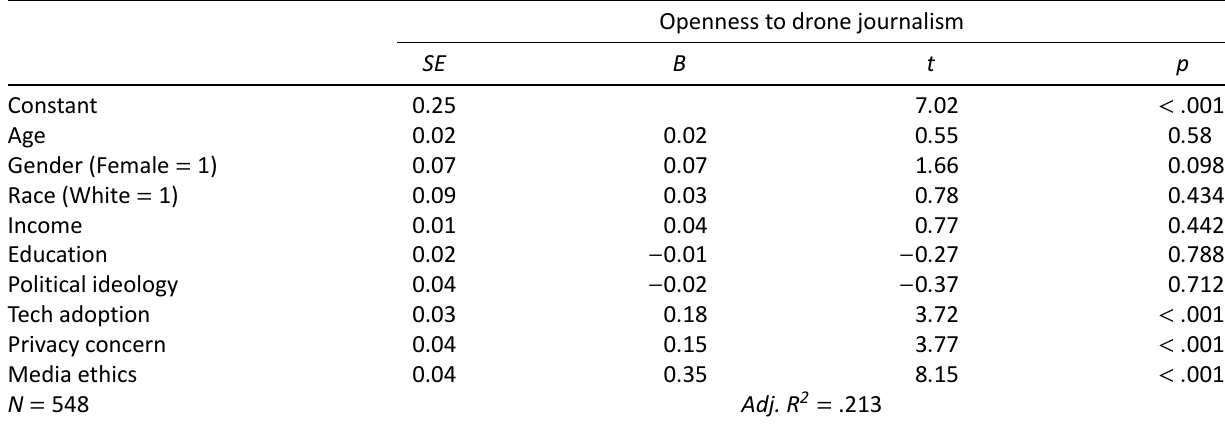
Table 5. The influence of privacy concerns, early technology adoption and perception of media ethics on the openness to civilian drone use.